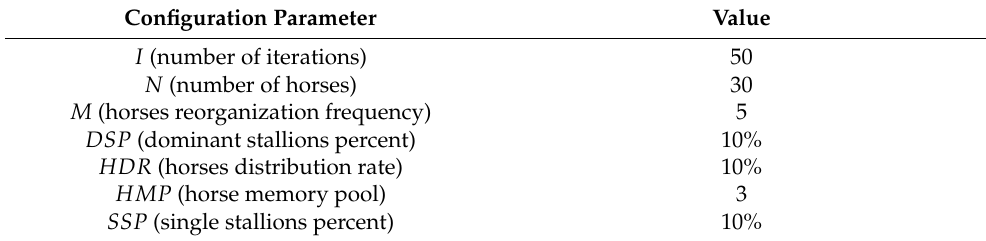
Table 3. BHOA Configuration Parameters.